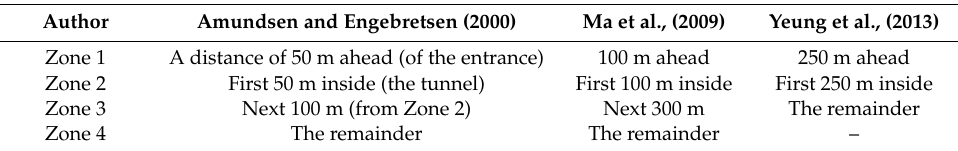
Table 1. Definition of Tunnel Zones by Three